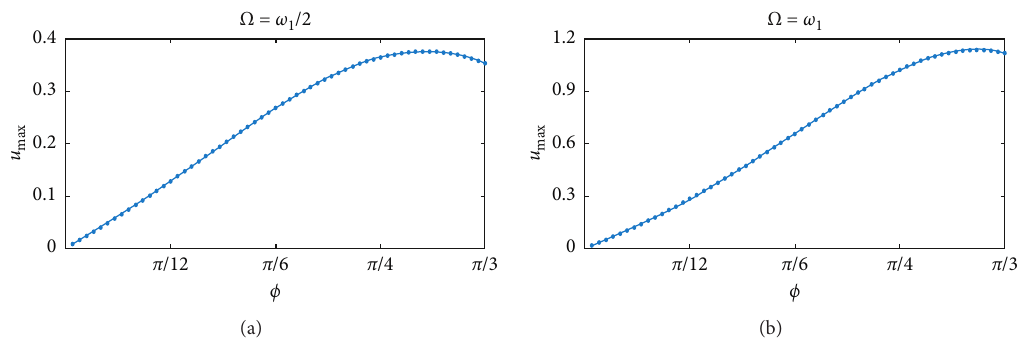
Figure 7: Response amplitude spectrum of the system at voltage excitation frequency ω